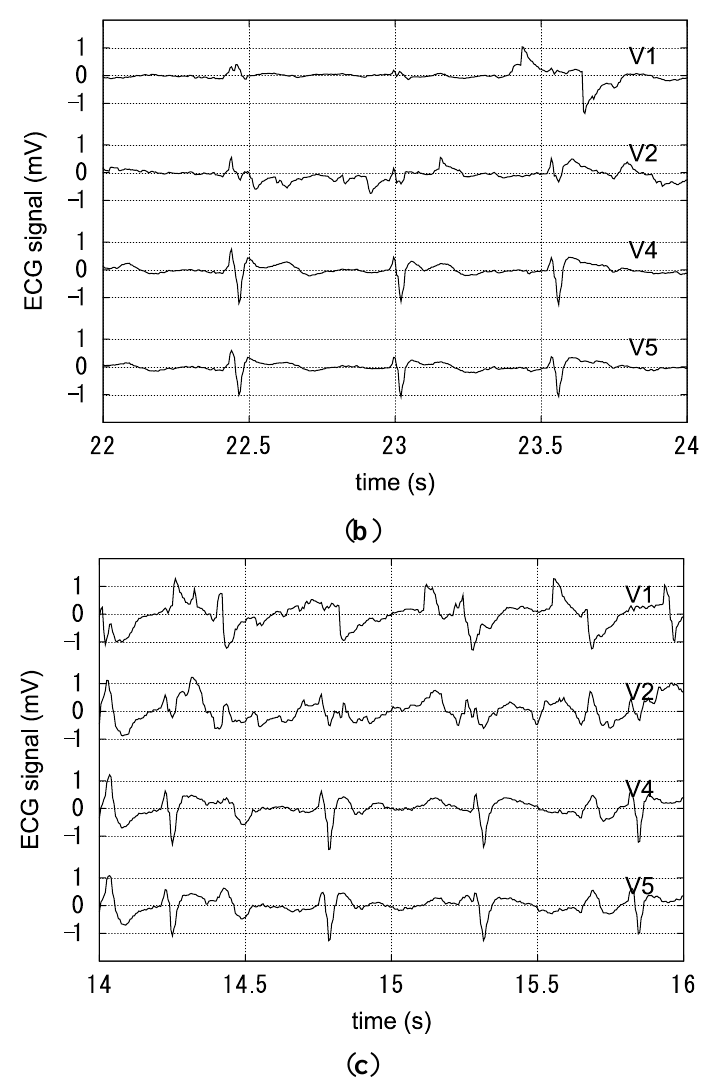
Figure 10. ECG signals measured by the smart shirt without the conductive foam blocks: ( a ) the subject resting in a chair; ( b ) the subject walking; ( c ) the subject slowly